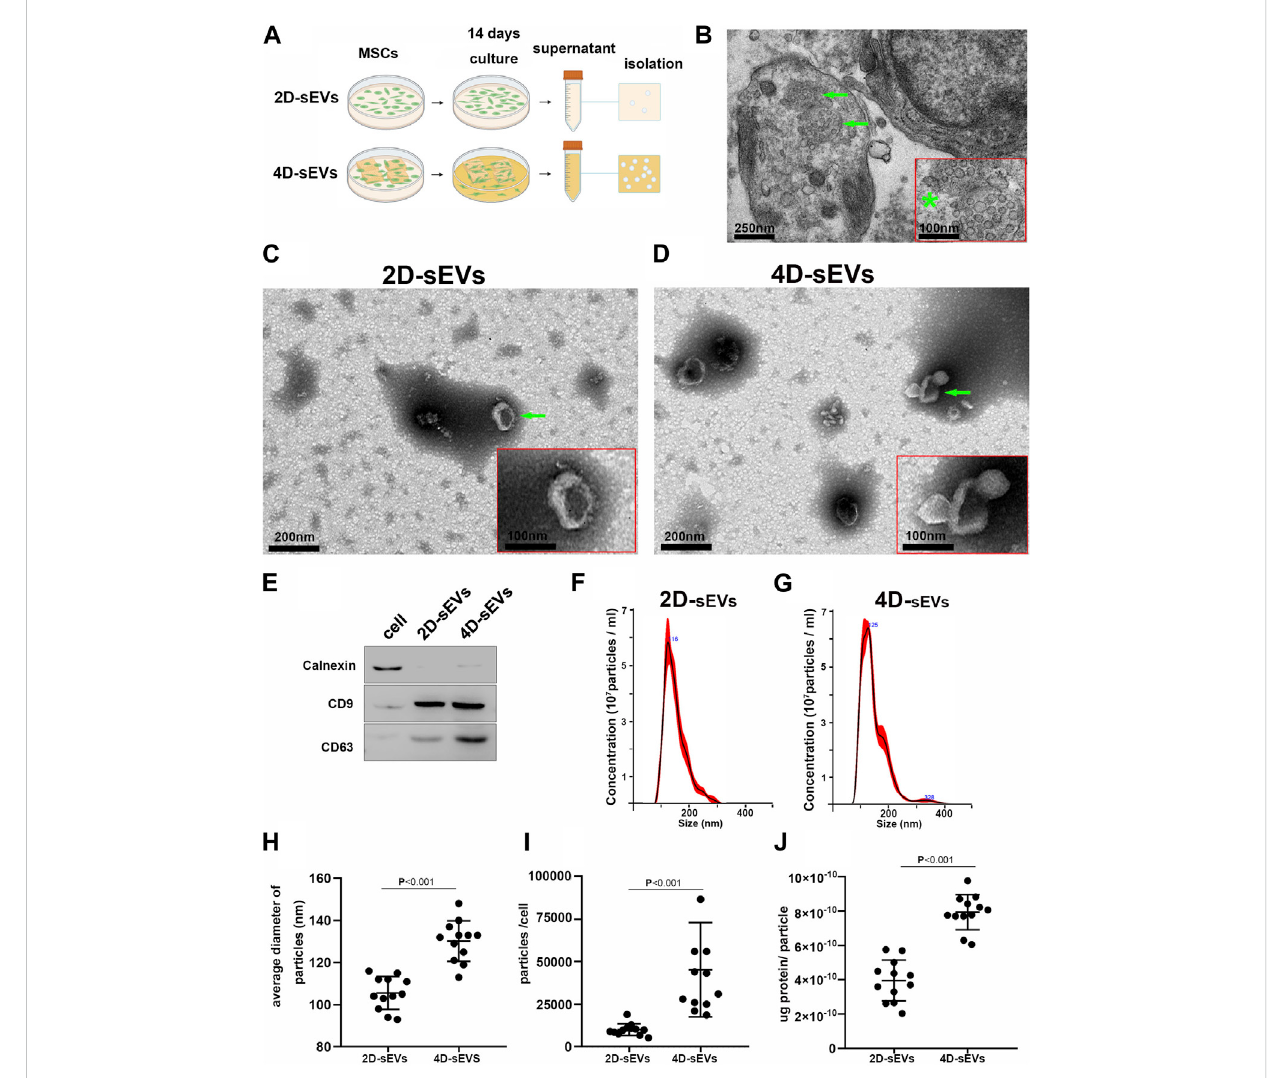
FIGURE 1 Acquisition and identi fi cation of four dimensional culture-derived sEVs (4D-sEVs). (A) Flow chart demonstrating the sEVs acquisition process. (B) Transmission Electron Microscopy (TEM) images of human umbilical cord mesenchymal stem cells (hUC-MSCs) in tissue-engineered fi broin scaffolds (3D scaffolds). The green arrow indicates exosome-like structures. * : The high magni fi cation of the structure (arrow) of (B) . (C, D) : TEM micrographs of sEVs. (E) : Western blot analysis for sEVs markers (CD9 and CD63). (F – G) : Size distribution of sEVs, as evaluated by Nanoparticle Tracking Analysis (NTA). (H) : Average sizes of sEVs. (I) : Yield of sEVs. (J) : Average protein amount of per